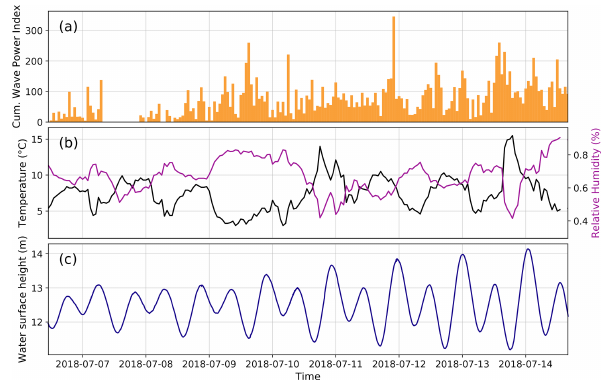
Figure A1. (a) Spatially cumulated wave power index determined with TeRACWA here presented as hourly sums; (b) air temperature and relative humidity recorded hourly. (c) Tide heights throughout the acquisition period obtained by applying a low-pass filter to the pressure sensor data with a 0.001Hz frequency cut-off then resam- pled to 5min.